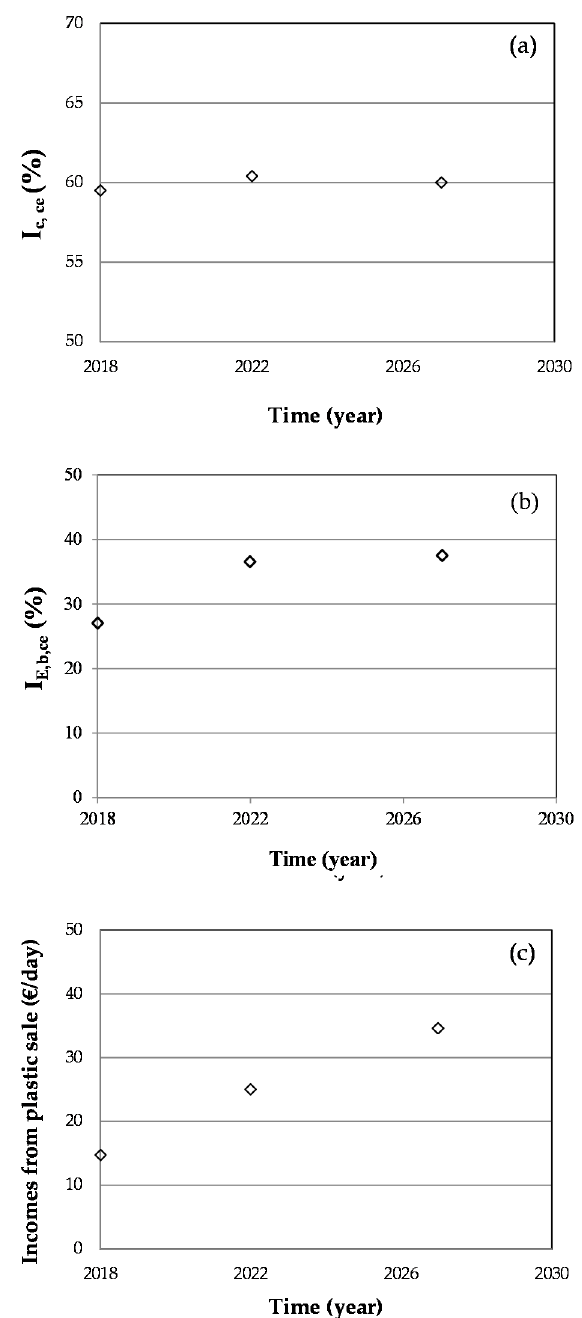
Figure 6. ( a ) Temporal evolution of percentage of biodegradable residue with respect to total residue generated on campus (I c,ce ). ( b ) Temporal evolution of percentage of energy supplied by biogas with respect to energy consumed on campus (I E,b,ce ). ( c ) Temporal evolution of income generated with the sale of plastic fraction in the city port.